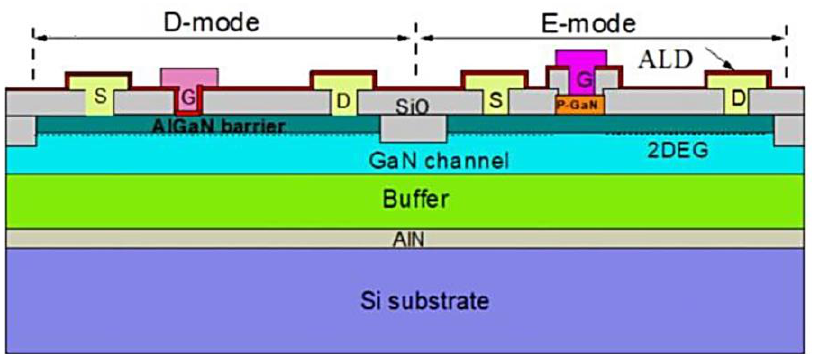
Figure 6. Schematic cross-section of E/D-mode GaN monolithic integration technology Adapted with permission from [142].